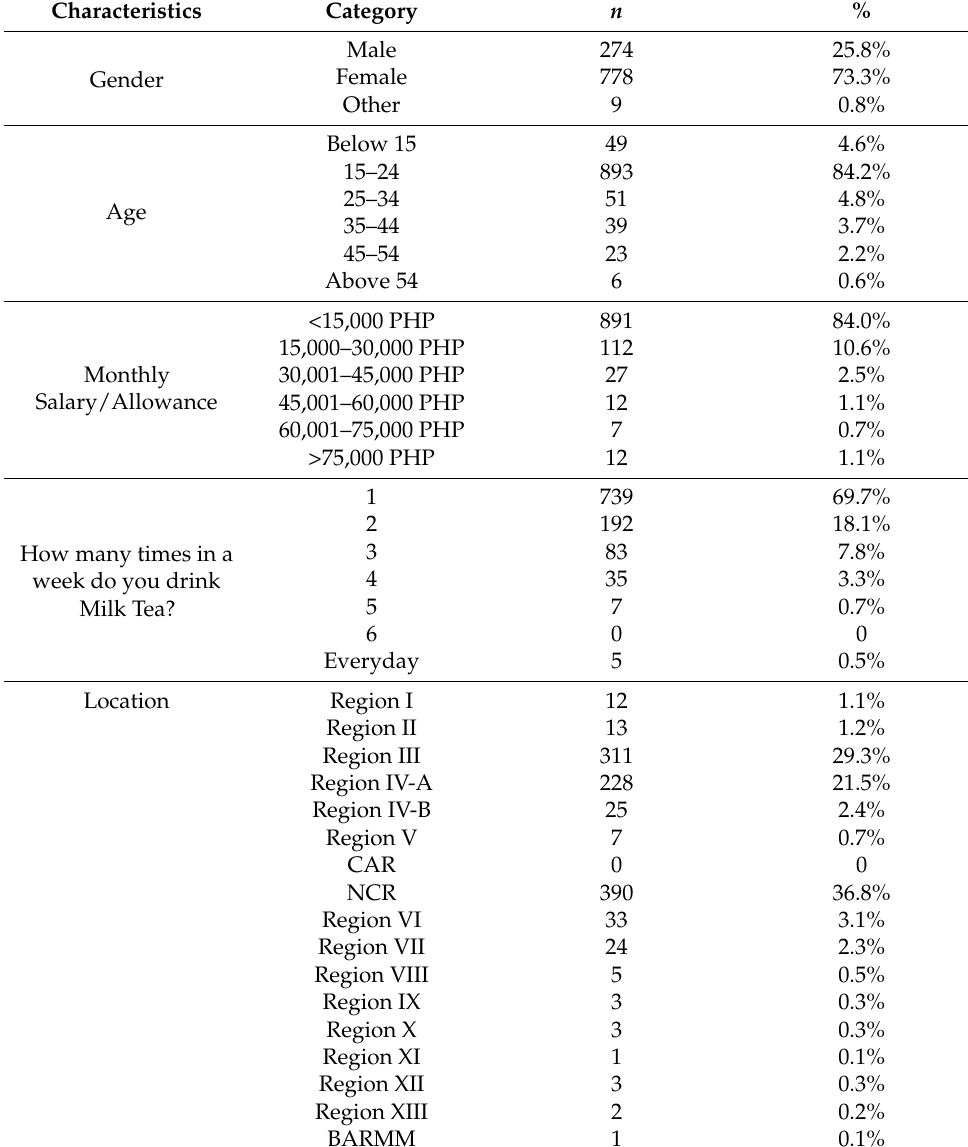
Table 1. Descriptive statistics of the respondents ( n =